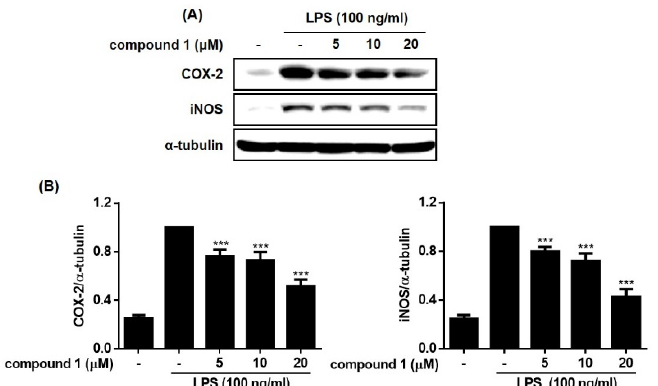
Figure 5. Compound 1 down-regulated the expression of inducible nitric oxide synthase (iNOS) and cyclooxygenase 2 (COX-2) in RAW264.7 cells stimulated with LPS. The RAW264.7 cells were pretreated with the compound (5, 10, and 20 µ M) for 1h before exposure to LPS for 24 h. The repre- sentative blots ( A ) and the calculated intensities ( B ) after normalization to α -tubulin were presented. Results are presented as the mean ± standard deviation from three independent experiments. The results differ significantly from LPS-only treated; *** p < 0.001.